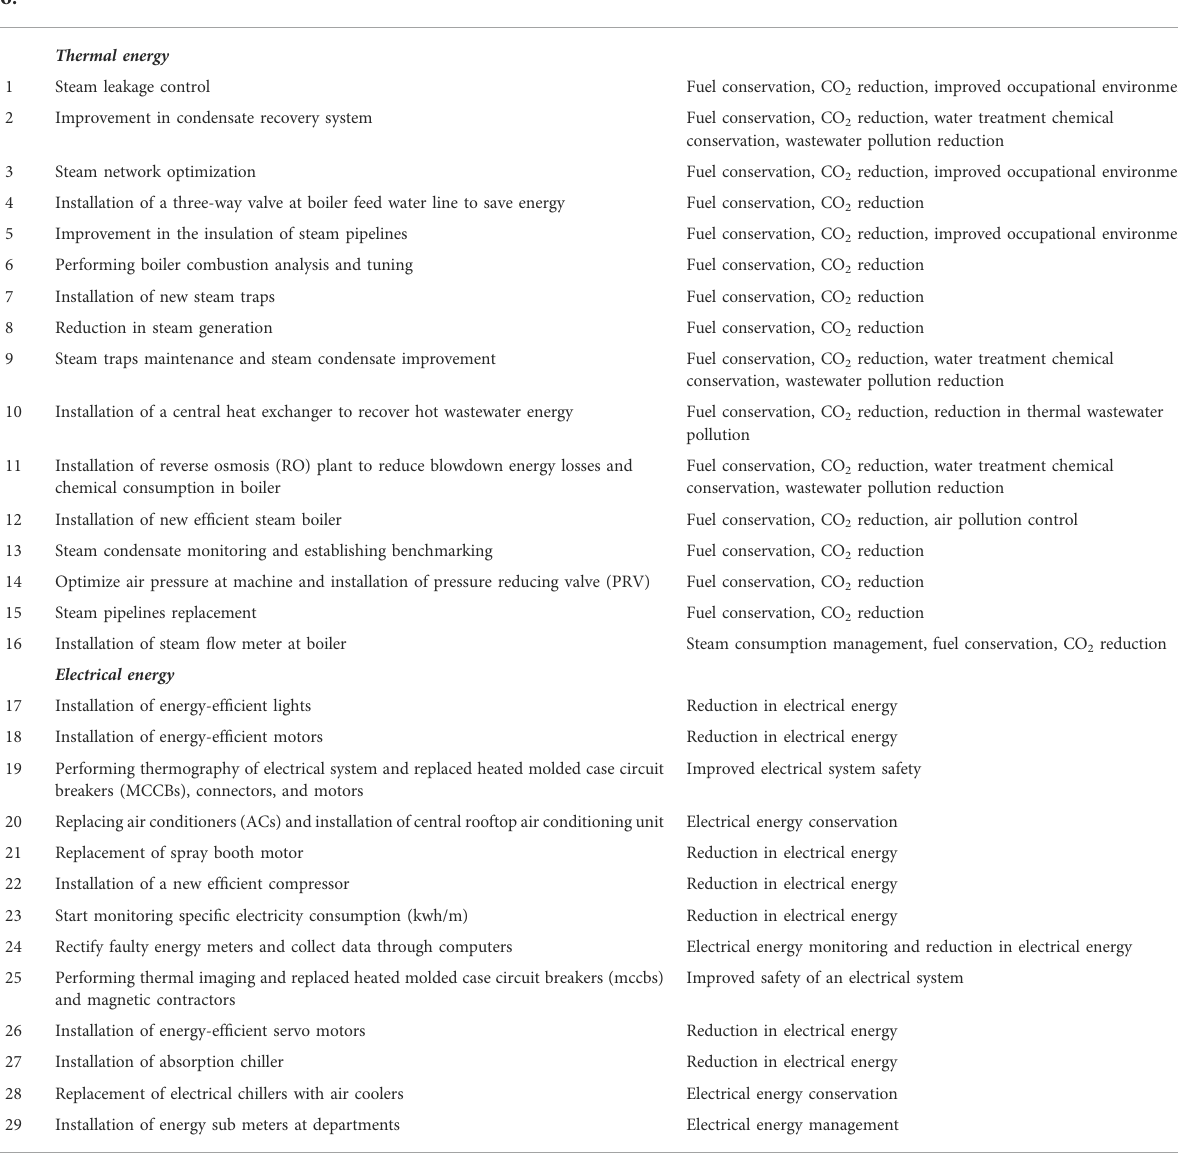
TABLE 11 Smart environmental management practices (SEMPs) and their bene fi ts for energy. S.